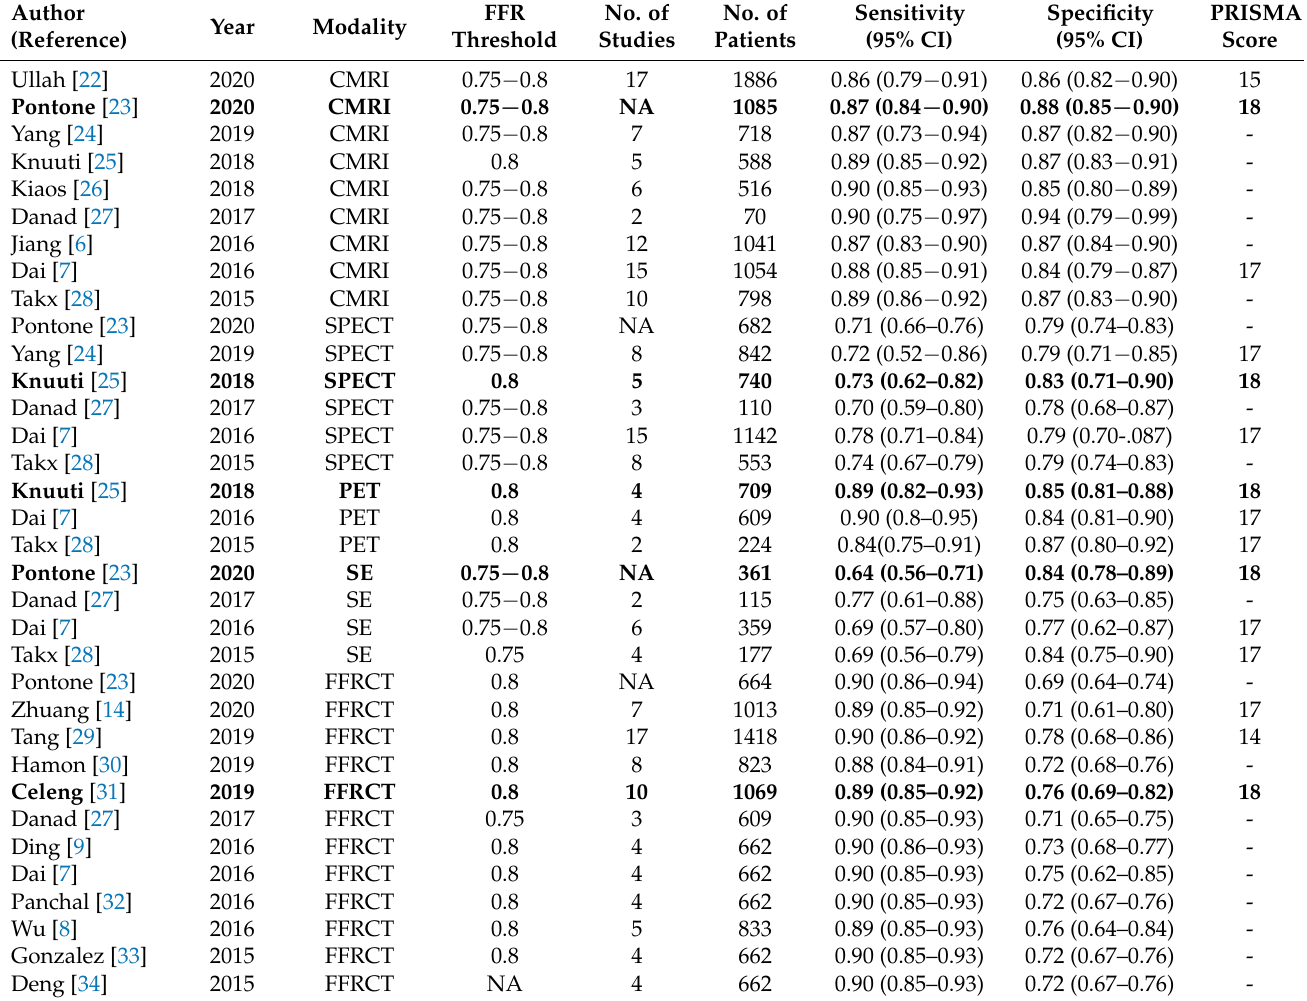
Table 2. List of candidate literature and their